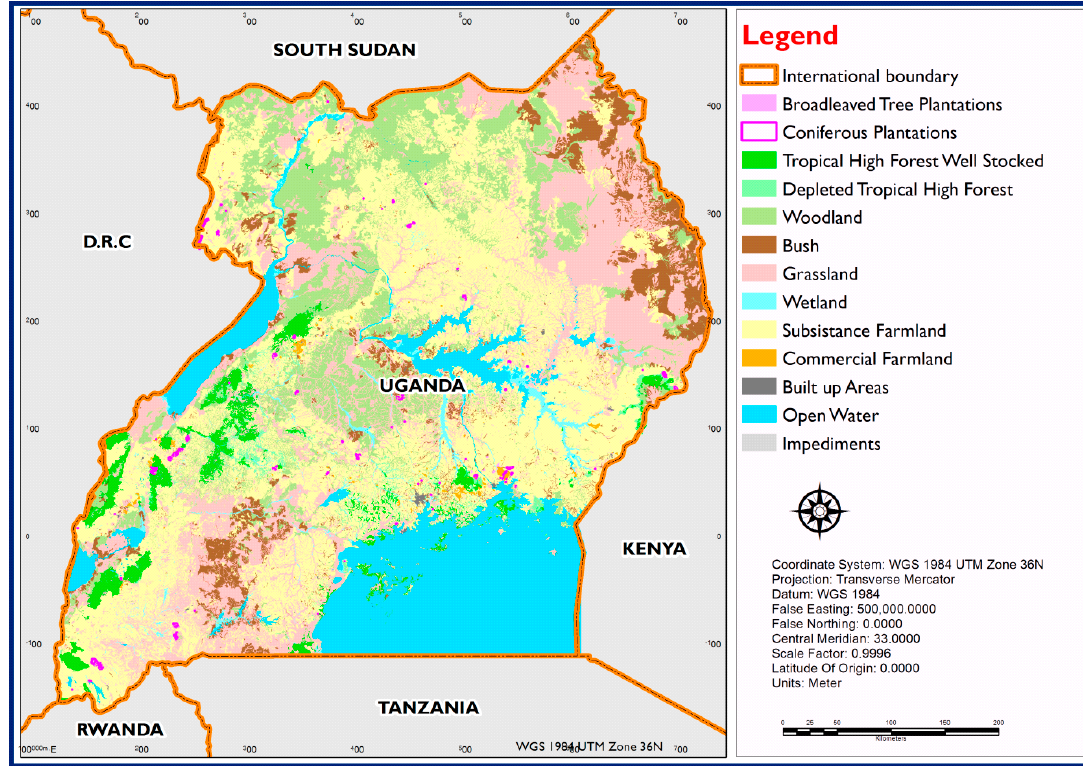
Figure 2. Land use/cover for Uganda for the year 1990. Table 1. Description of the National Biomass Study’s land use/cover classes (1990).